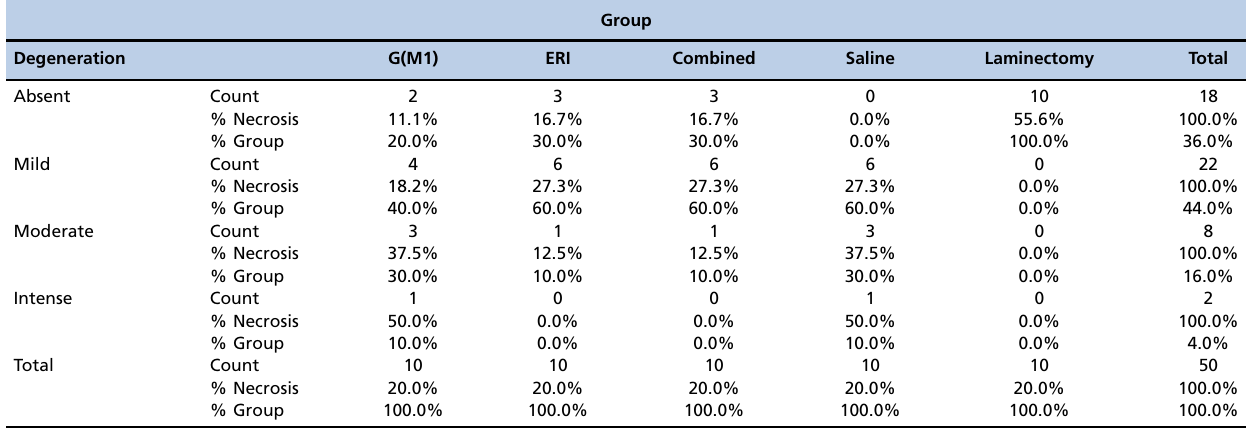
Table 6 - Axonal degeneration in the distal section of the spinal cord in Wistar rats subjected to experimental spinal cord contusion lesioning.